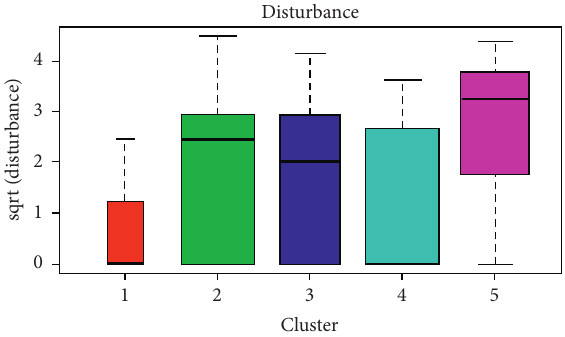
Figure 4: Boxplot showing the association of disturbance with plant community types.